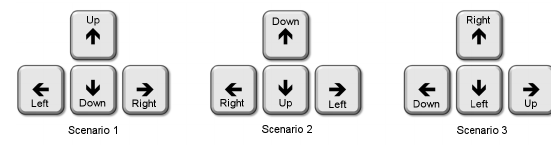
Figure 4. Control